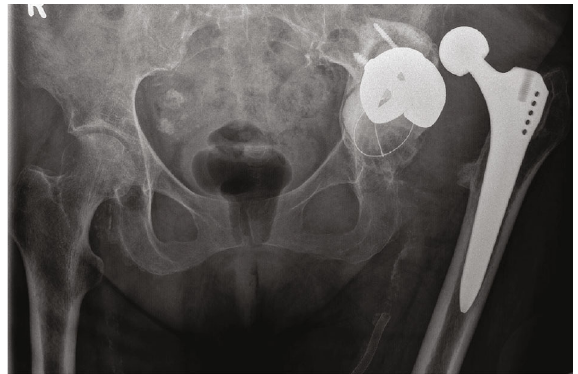
Figure 5: Follow-up X-ray demonstrating left hip dislocation at 4 weeks postop.